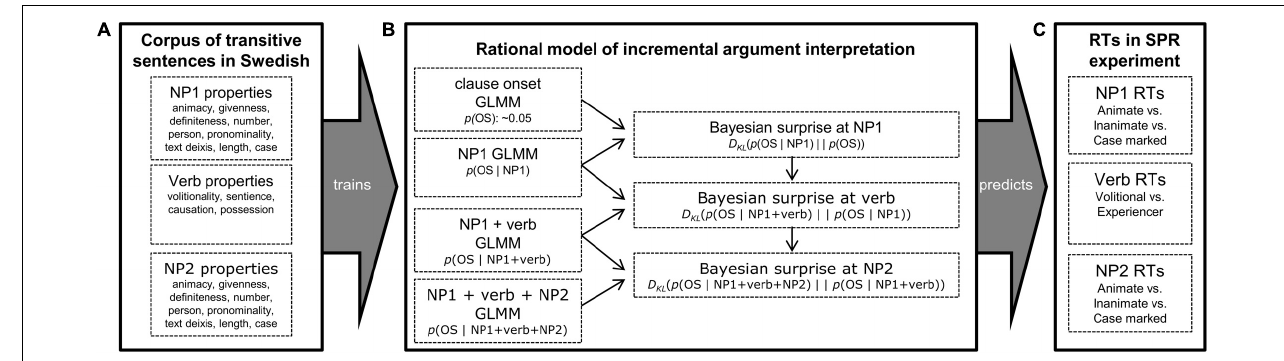
FIGURE 1 | Illustration of the approach taken in the present study. Panel A: A corpus of 16,552 transitive clauses in written Swedish is created and annotated for 16 different cues to argument interpretation. Panel B: From this corpus, the probability of OS vs. SO order is estimated at four different sentence regions, using all cues available up to that point in the sentence. The Bayesian surprise at each sentence region—quantifying the incremental change in expectations about argument interpretation—is then derived from these probabilities. Panel C: The rational model is tested by predicting human reading times at different sentence regions from the model-predicted Bayesian